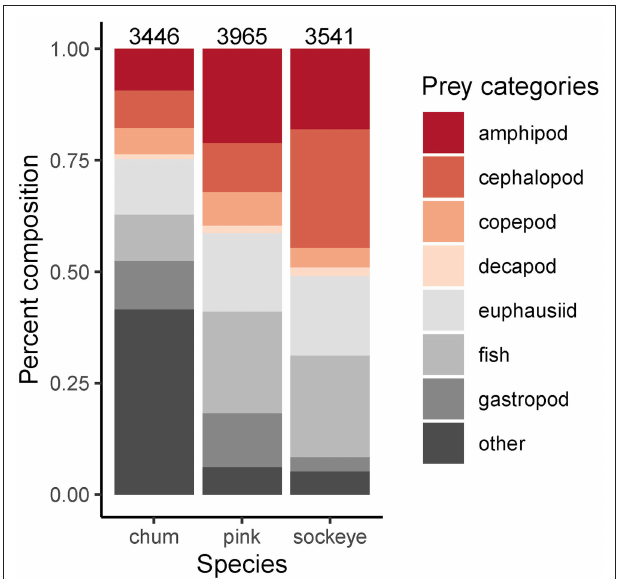
FIGURE 2 | Average proportional diet composition by species across the North Pacific. Known sample sizes (total number of salmon) are displayed above each bar. These numbers are an underestimate of the actual sample size since it was not always reported in the source.